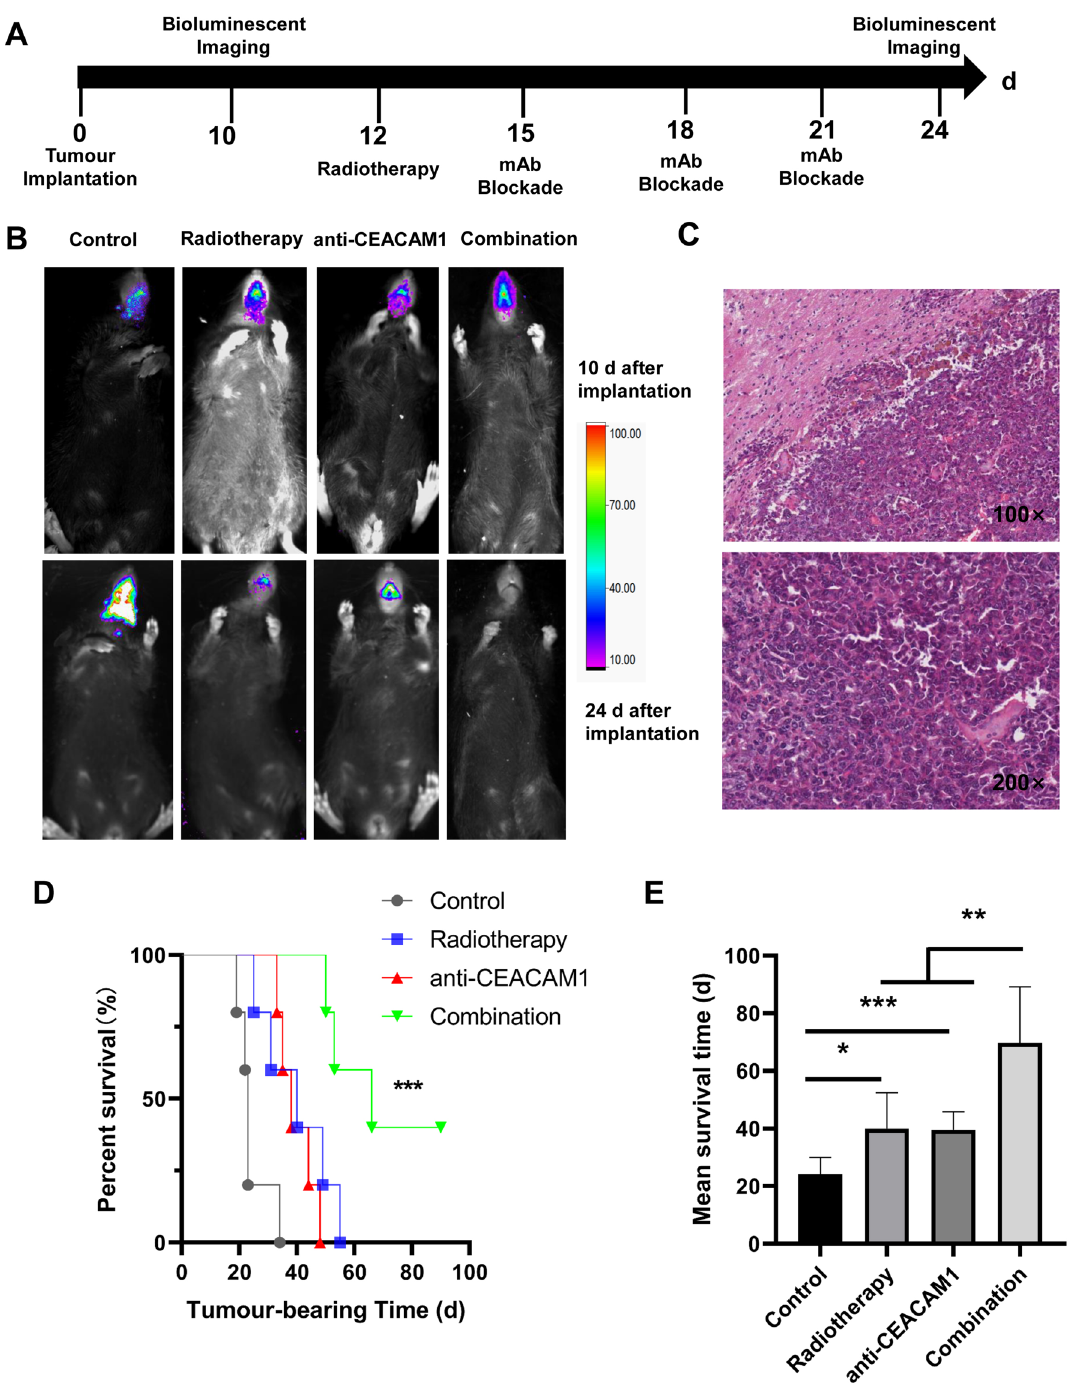
Fig. 2 Growth of in situ gliomas and survival of mice in different treatment groups. A Study timeline. B Representative images at 10 and 24 d after tumour implantation in different groups; at 10 d, the number of photons for the 4 mice (from left to right) were: 386596 P/s, 914306 P/s, 454961 P/s, and 871112 P/s; at 24 d the numbers were: 4658120 P/s, 225346 P/s, 697543 P/s, and 0 P/s). C Images of HE-stained murine tumours. D Survival curves of mice in different groups. E Mean survival time of mice in different groups. *: P < 0.05, **: P < 0.01, ***: P <